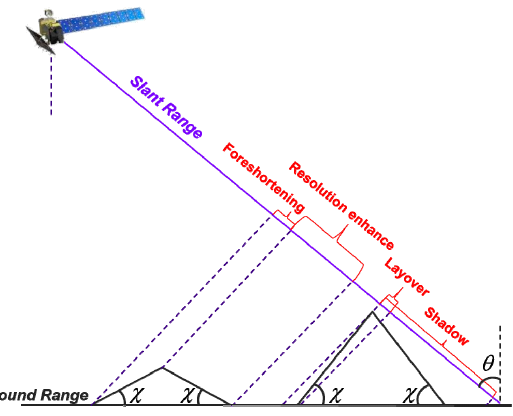
Figure 2. Geometric distortion effects in the Synthetic Aperture Radar (SAR) image.